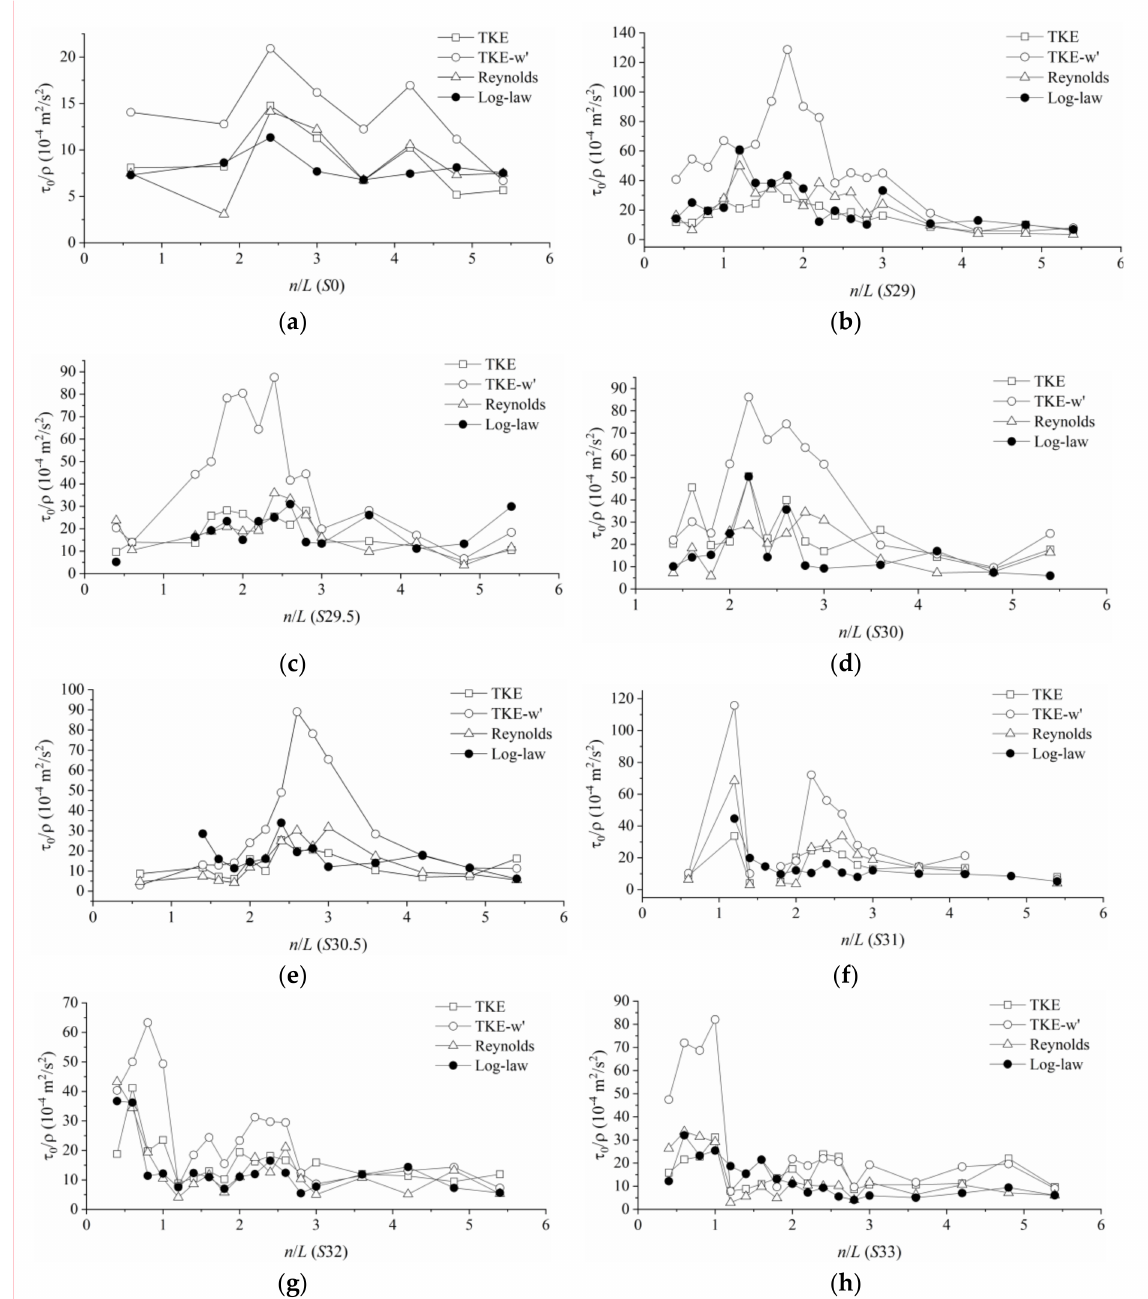
Figure 4. Comparison of results from four methods for bed shear stress estimates in selected sections: ( a ) S 0; ( b ) S 29; ( c ) S 29.5; ( d ) S 30; ( e ) S 30.5; ( f ) S 31; ( g ) S 32; ( h ) S